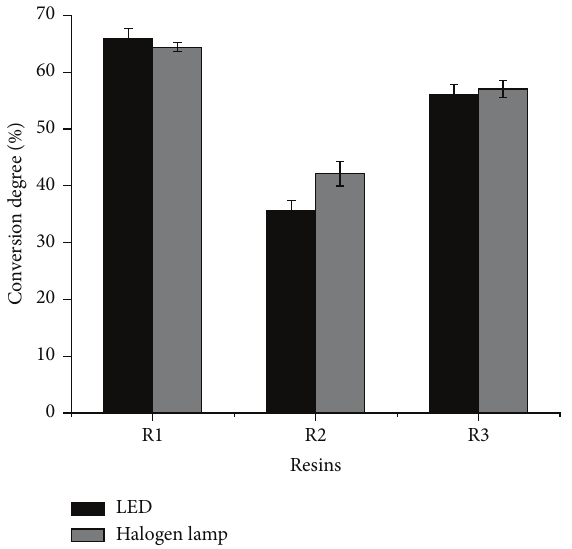
Figure 4: Graph of the mean and standard deviation for the 𝑡 max for the three resins (R1, R2, and R3) photoactivated by two light sources (LED and halogen